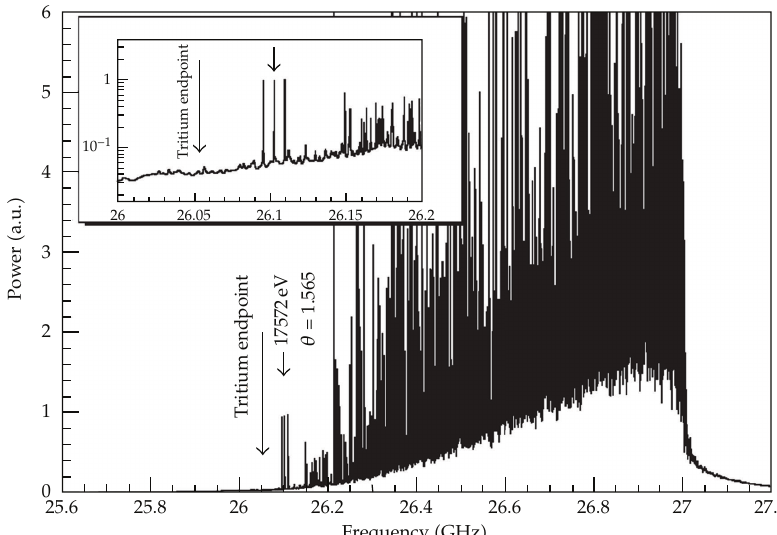
Figure 28: Simulated frequency spectrum of 10 5 tritium decays observed within a 30 𝜇 s interval in a 10m long source with a field of 1T. The inset shows the triplet of lines produced by a high energy electron (reprinted with permission from [170], Copyright (2009) by the American Physical